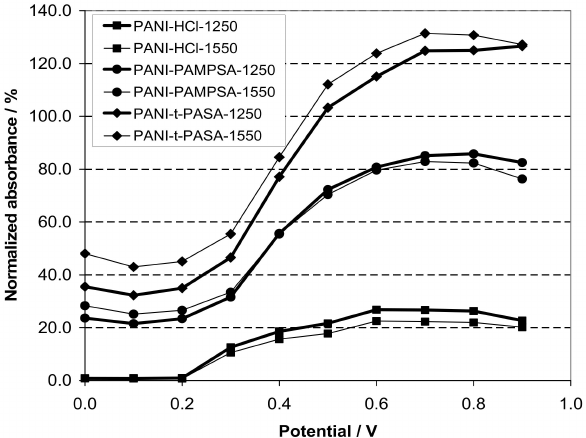
Figure 16. Changes of normalized (to the absorbance of localized polarons 750 nm) absorbance at 1250 and 1550 nm depending on the potential for the films of ordinary PANI and different composites. Reprinted by permission from Springer Nature Customer Service Centre GmbH: Springer Nature, Journal of Solid State Electrochemistry, “Electroactive films of interpolymer complexes of polyaniline with polyamidosulfonic acids: advantageous features in some possible